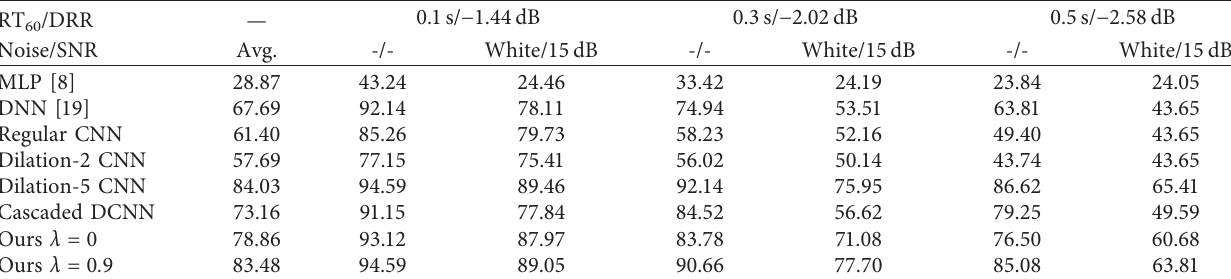
Table 3: Localization accuracy (%) of different approaches in the noisy and reverberant scenes. RT 60 /DRR